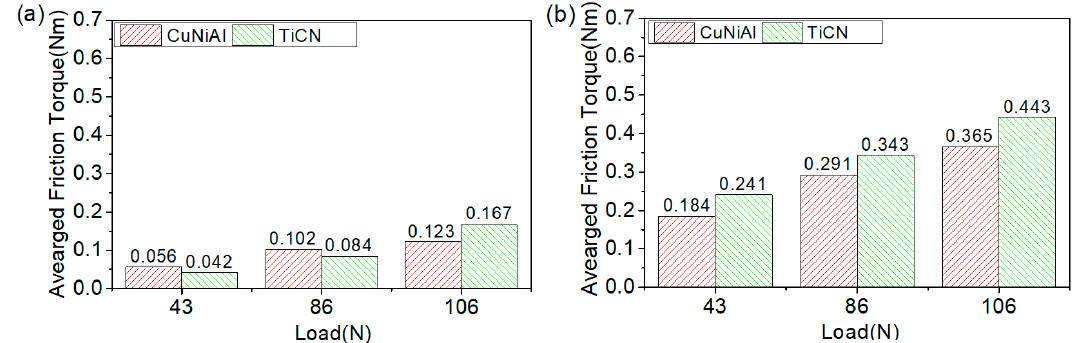
Figure 9. Stable friction torque: ( a ) in oil; and ( b ) in artificial seawater.